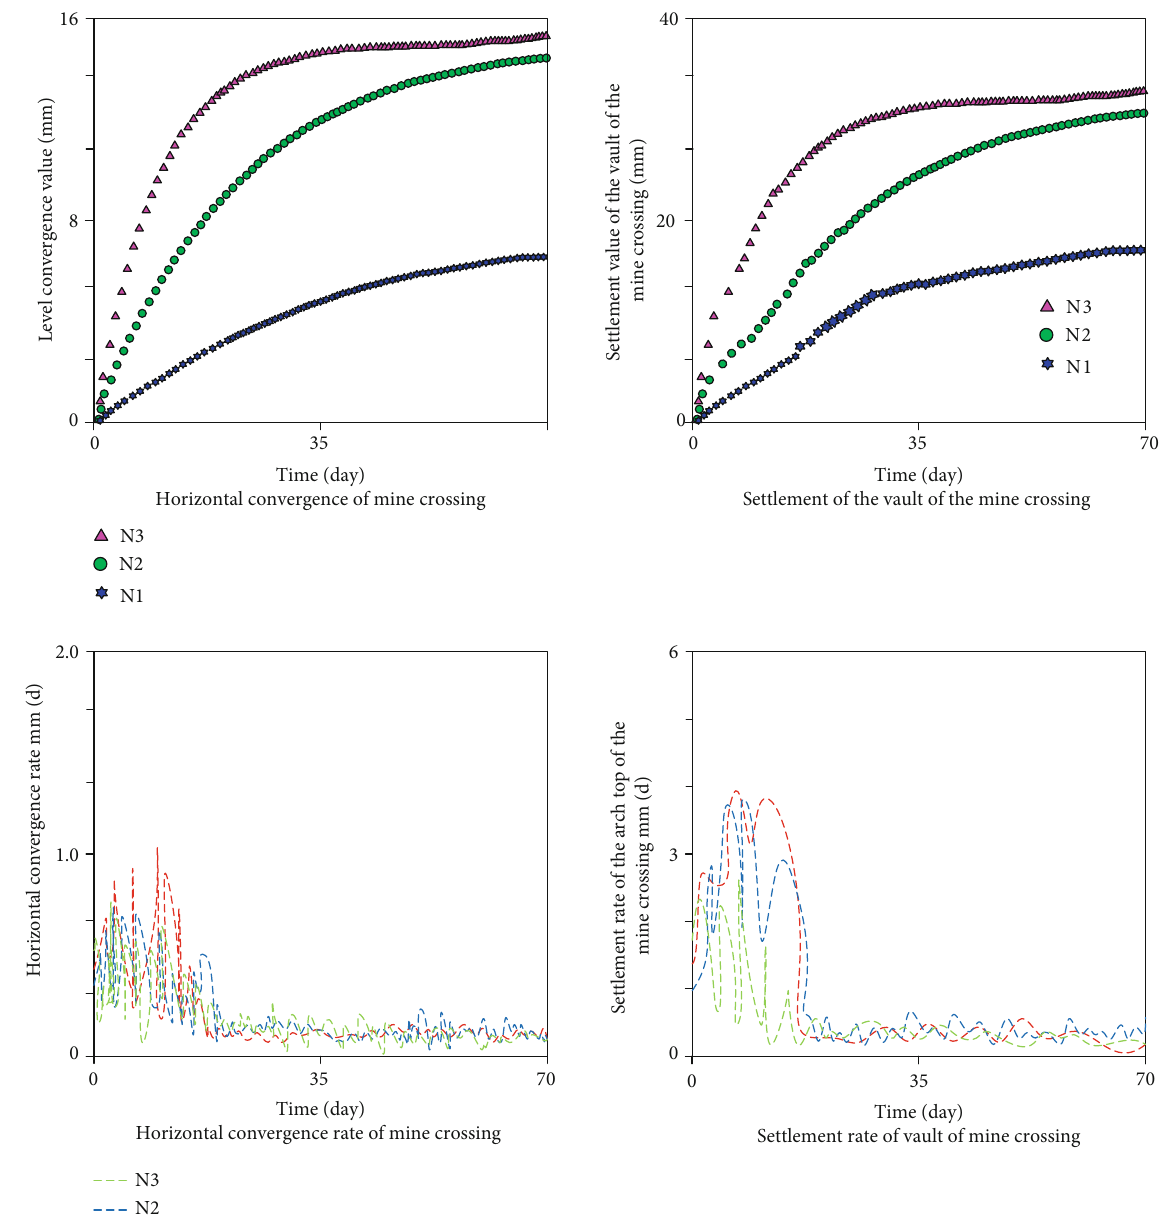
Figure 6: Data curve of the coal mine opening